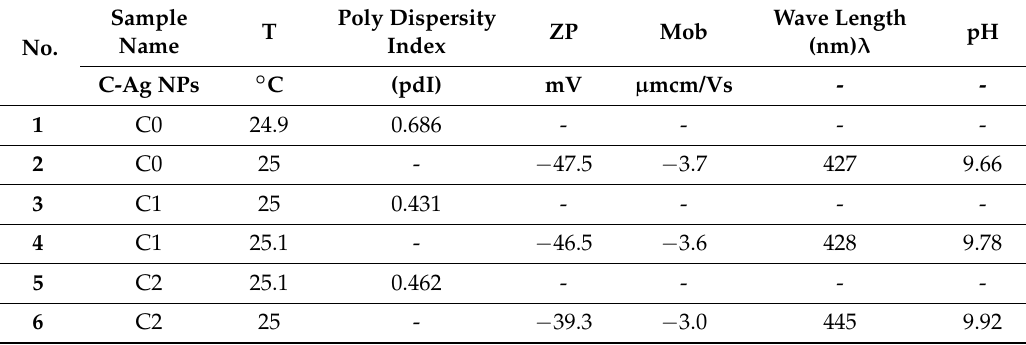
Table 1. Characteristics of C-Ag NPs synthesized from the curcumin samples C2, C1, and C0.